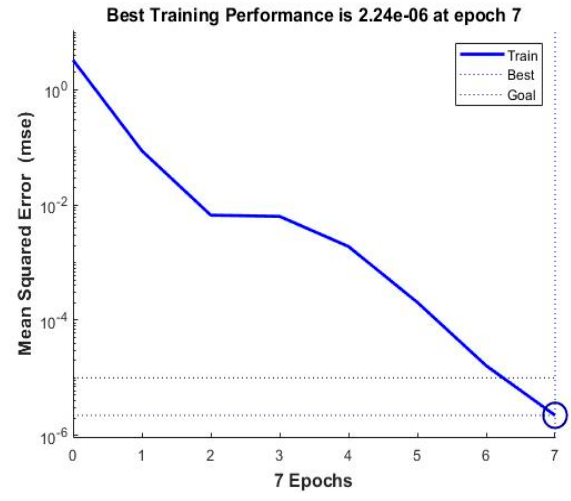
Figure 7. The number of iterations of the GA-BP algorithm. Table 2. BP algorithm test data.